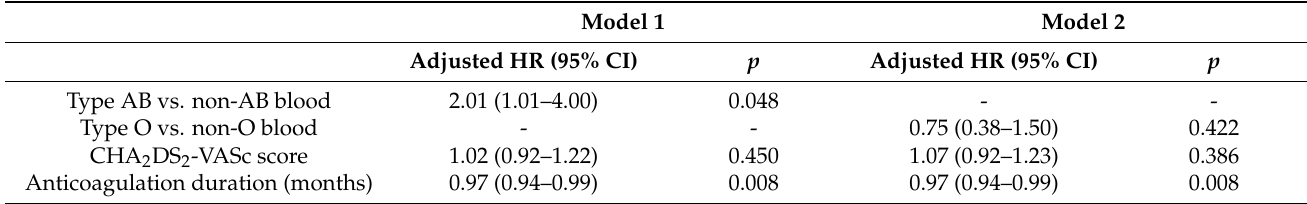
Table 3. Multivariable Cox regression analysis of long-term clinical